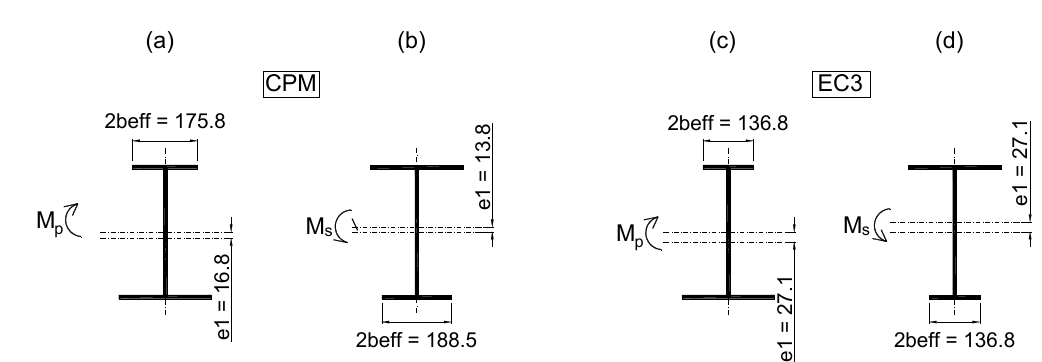
Figure 9. E ff ective cross-sections of the I-300 × 5 × 250 × 5 section according to CPM and EC3 methods. ( a ) span cross-section acc. CPM, ( b ) support cross-section acc. CPM, ( c ) span cross-section acc. EC3, ( d ) support cross-section acc. EC3.